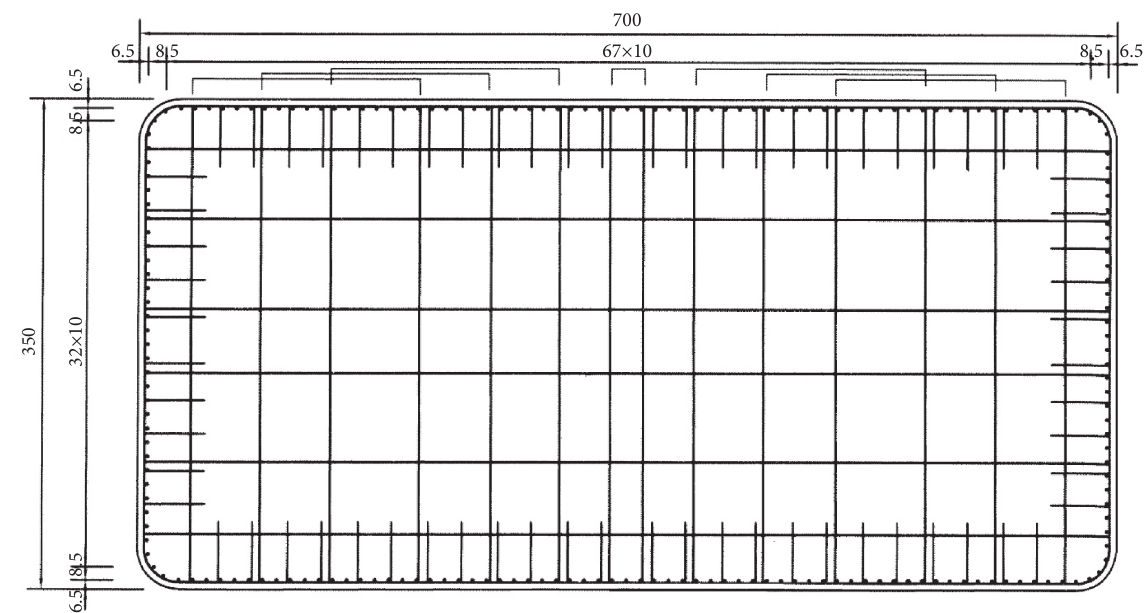
Figure 3: Reinforcement layout of the pier bottom section (dimension units: cm). Table 1: Comparatively researched construction stages.